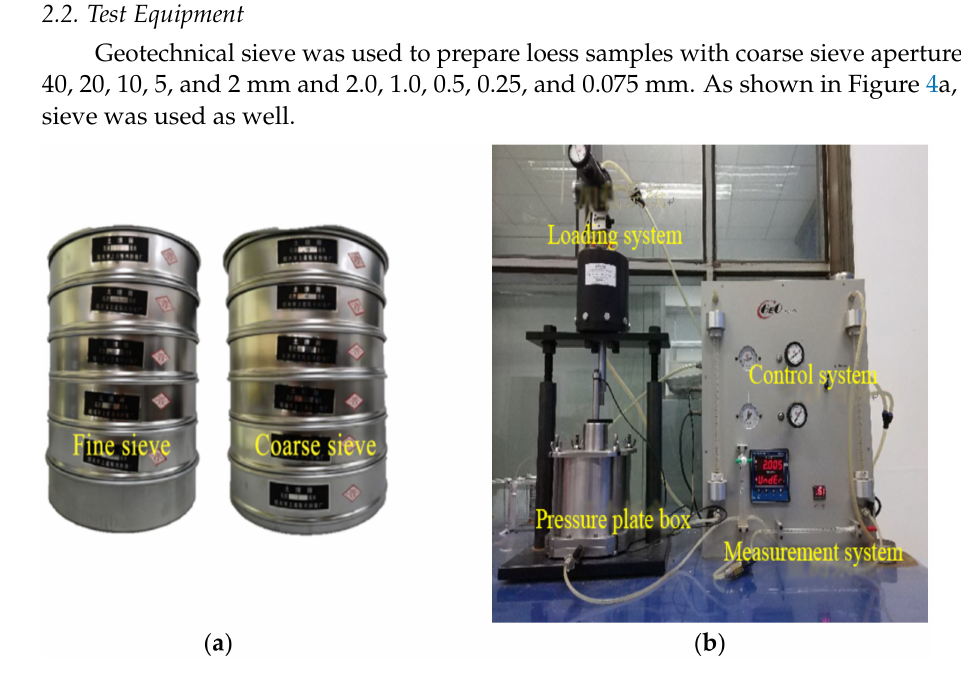
Figure 4. ( a ) Geotechnical sieve; ( b ) oedometer-type pressure plate SWCC